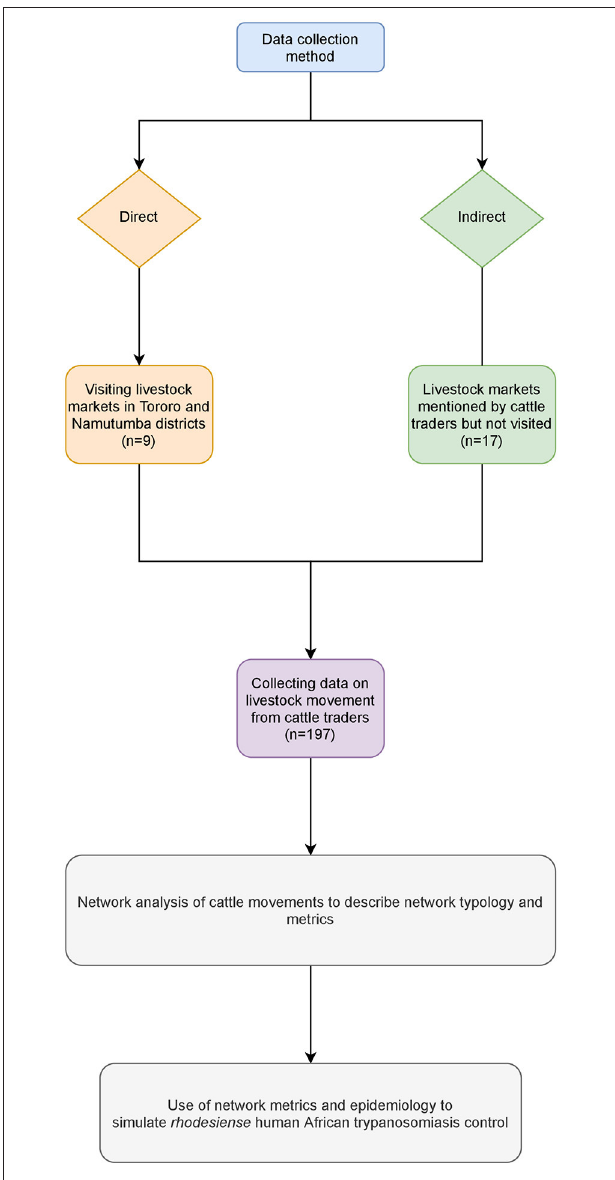
FIGURE 1 | Cattle movement data collection and analysis methods.